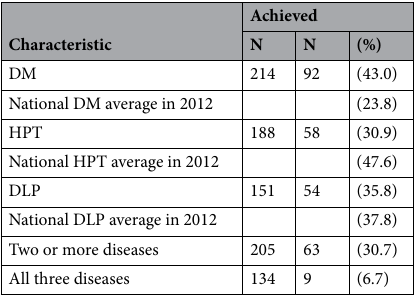
Table 2. Therapeutic target achievement for DM, HPT, and